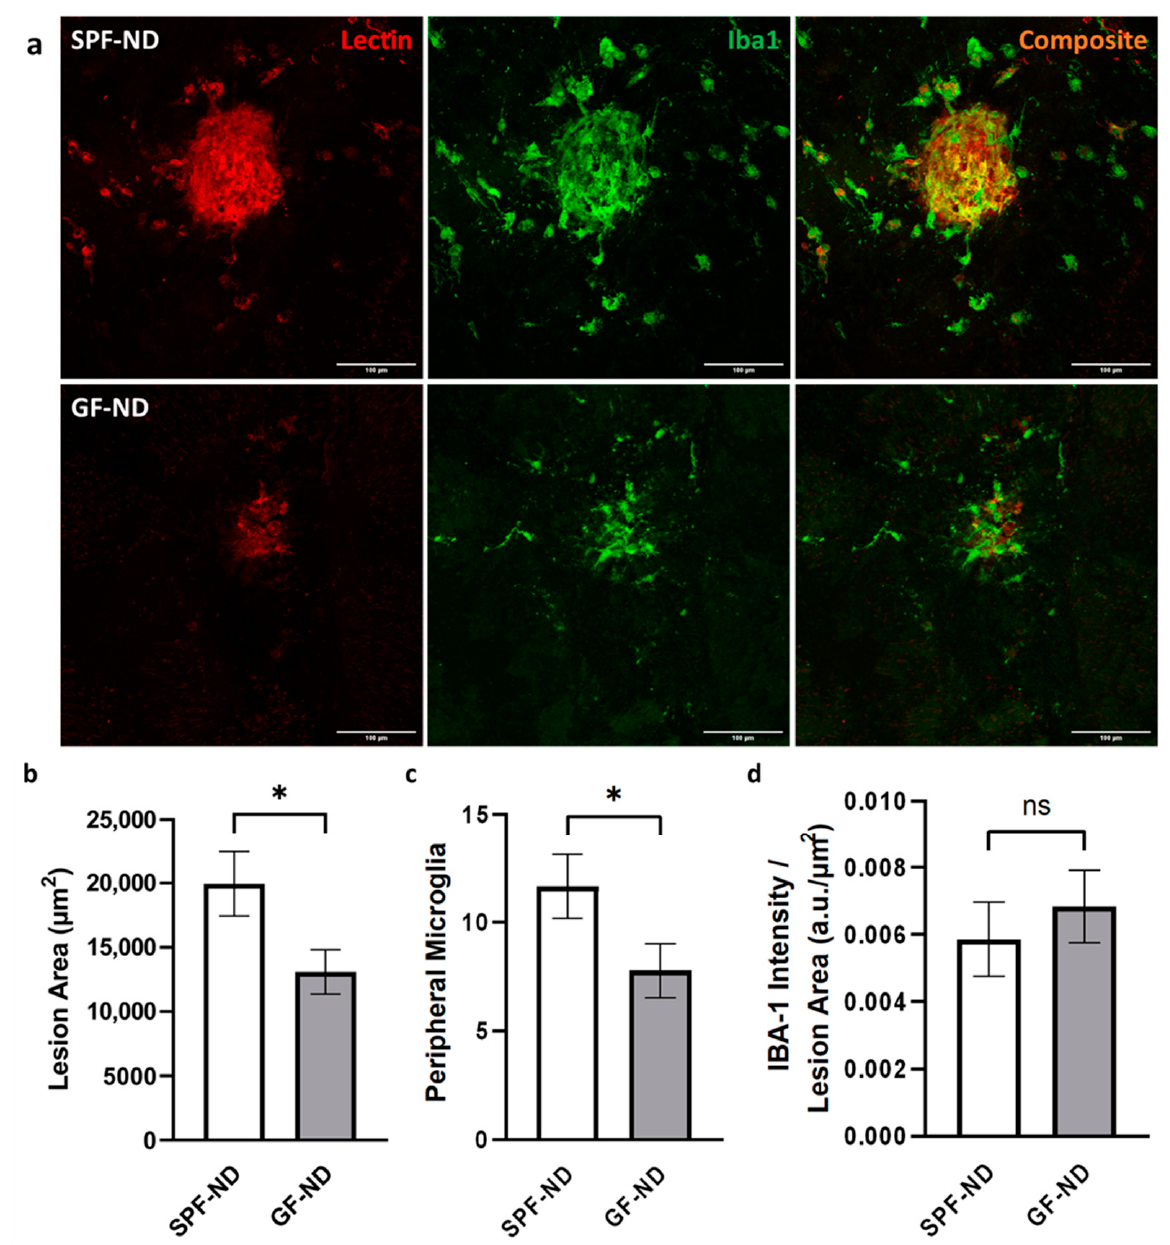
Figure 5. ( a ) Representative confocal images of laser-induced CNV lesions in SPF-ND and GF-ND mice. Scale bar = 100 μ m. ( b – d ) Quantification of CNV lesion area ( b ), microglia surrounding the lesion ( c ), and IBA-1 signal intensity within given lesion area ( d ). GF-ND mice showed a reduction in both CNV lesion area and peripheral microglia activation ( p < 0.05). * p < 0.05, ns: not statistically significant.